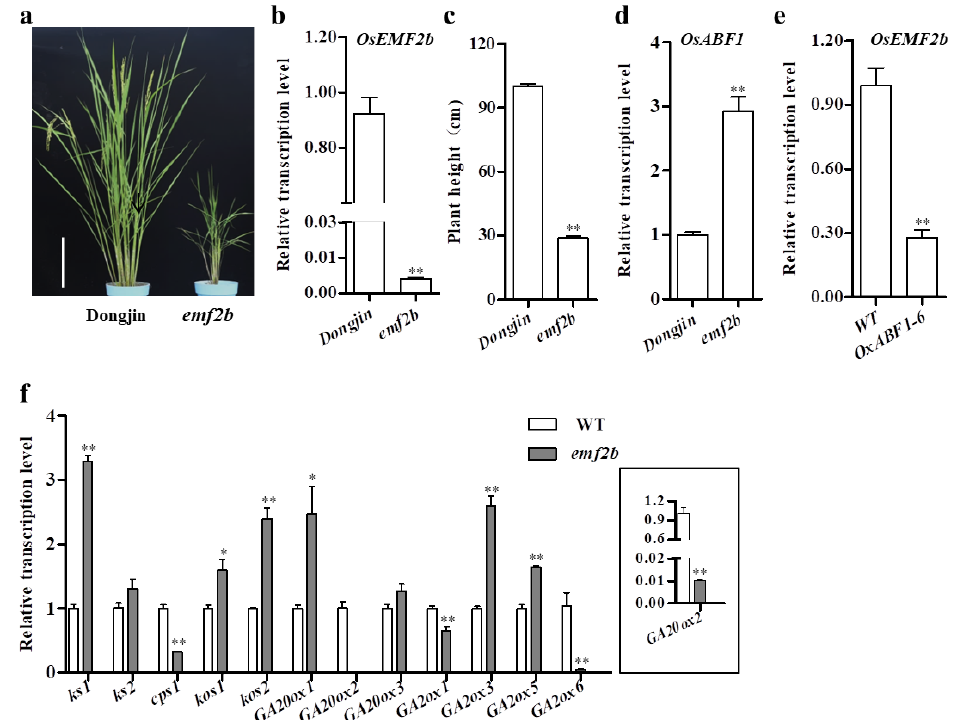
Figure 5. The plant height of emf2b was reduced. ( a ) The phenotype of WT (Dongjin) and emf2b . ( b , d ) OsEMF2b and OsABF1 transcriptional level in WT (Dongjin) and emf2b leaves at tillering stage. ( c ) The plant height of WT (Dongjin) and emf2b. ( e ) OsEMF2b transcriptional level in WT (Nipponbare) and OxABF1-6 leaves at tillering stage. ( f ) The expression levels of GA-related genes in WT (Dongjin) and emf2b leaves at tillering stage. Throughout this figure, * p < 0.05, ** p < 0.01 by Student’s t -test